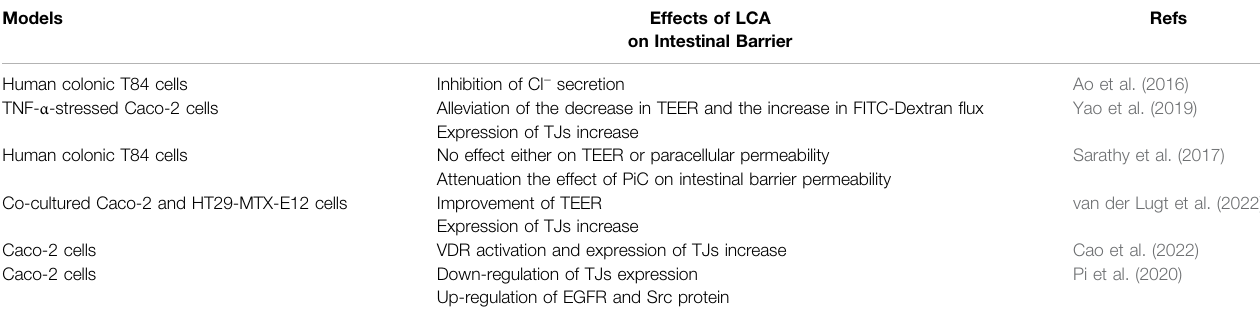
TABLE 1 | Effects of LCA on intestinal barrier in different